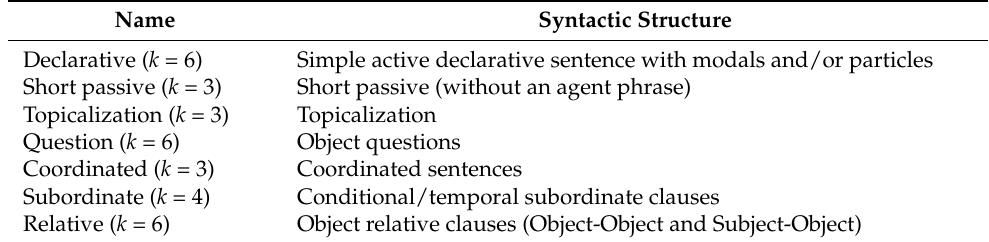
Table 2. Structures used in the Arabic